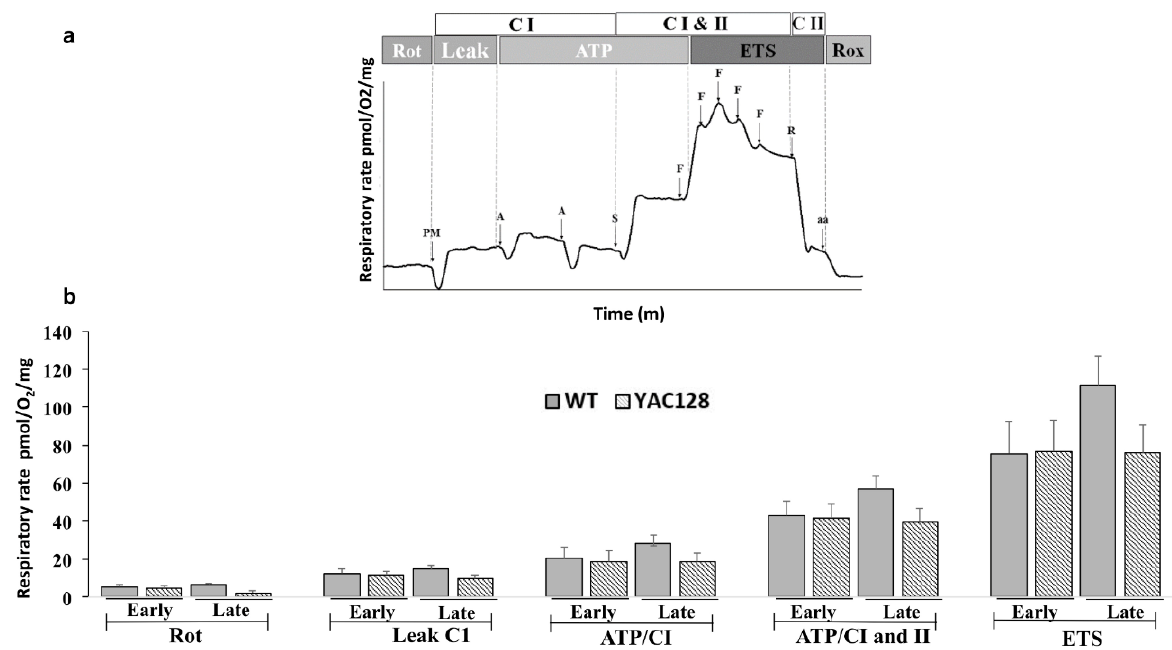
Figure 4. Mitochondrial respiratory activity in hippocampal homogenates from early (3 to 4 months) and late (11–13 months) symptomatic YAC128 mice and their age-matched WT counterparts. Rep- resentative traces of the main mitochondrial parameters calculated ( a ) and the respiratory states from hippocampal homogenates in WT and YAC128 mice ( b ). Rot—the rate of basal O 2 consump- tion, Leak—O 2 consumption rate associated with Complex I independent of ADP, ATP/CI and ATP/CI and II—the rate of O 2 consumption associated with ATP production-related only to complex I (ATP/CI) and to complex I and II (ATP/CI and II), respectively, and ETS—maximal mitochondrial respiration. Statistical analysis of the respiratory rates was performed using two-way ANOVAs, and the values were expressed as the means ± SEM. Abbreviations: CI—complex I, CII—complex